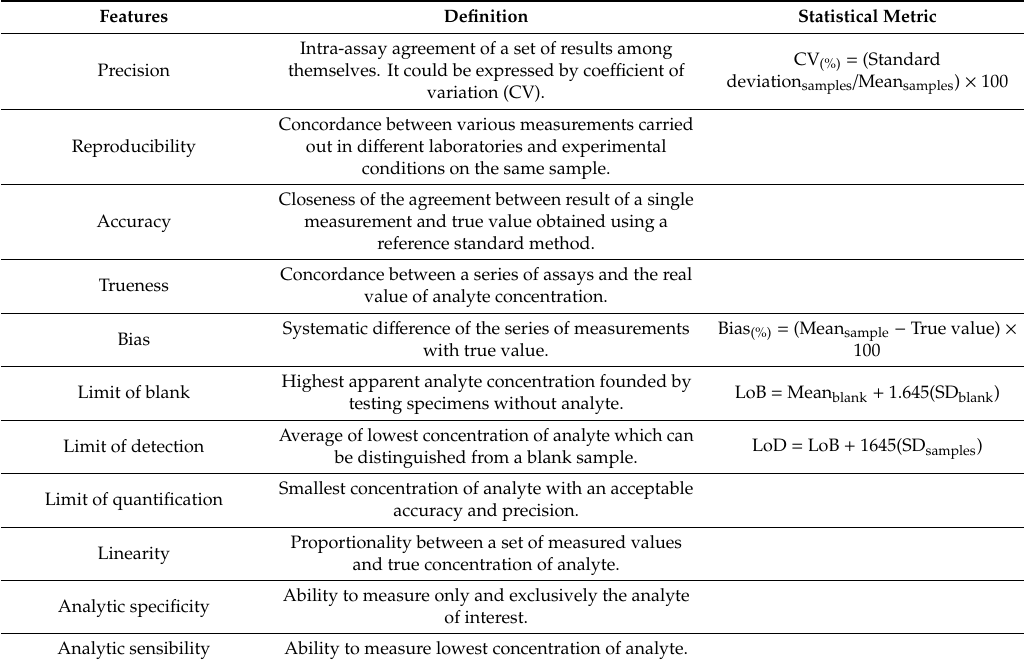
Table 2. Principal tools used to assess analytic